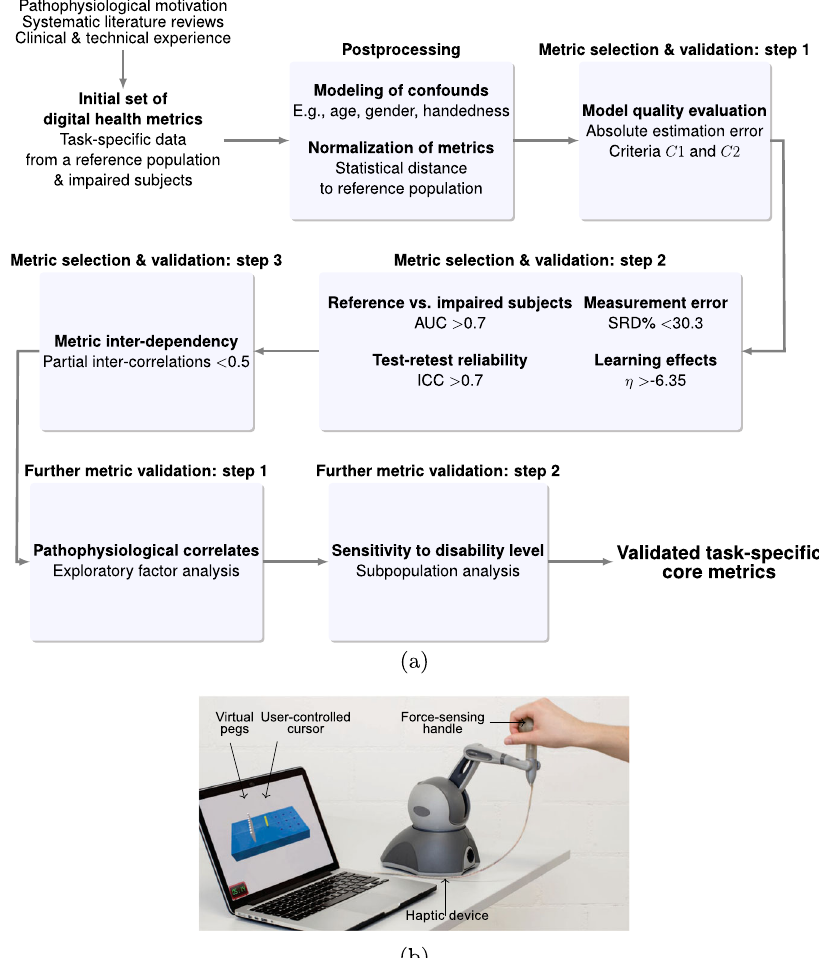
Fig. 1 Overview of the metric selection framework and the Virtual Peg Insertion Test (VPIT). a The frameworks allows to select a core set of validated digital health metrics through a transparent step-by-step selection procedure. Model quality criteria C 1 and C 2; ROC receiver operating characteristics, AUC area under curve, ICC intra-class correlation, SRD% smallest real difference; η strength of learning effects. b The framework was applied to data recorded with the VPIT, a sensor-based upper limb sensorimotor assessment requiring the coordination of arm and hand movements as well as grip